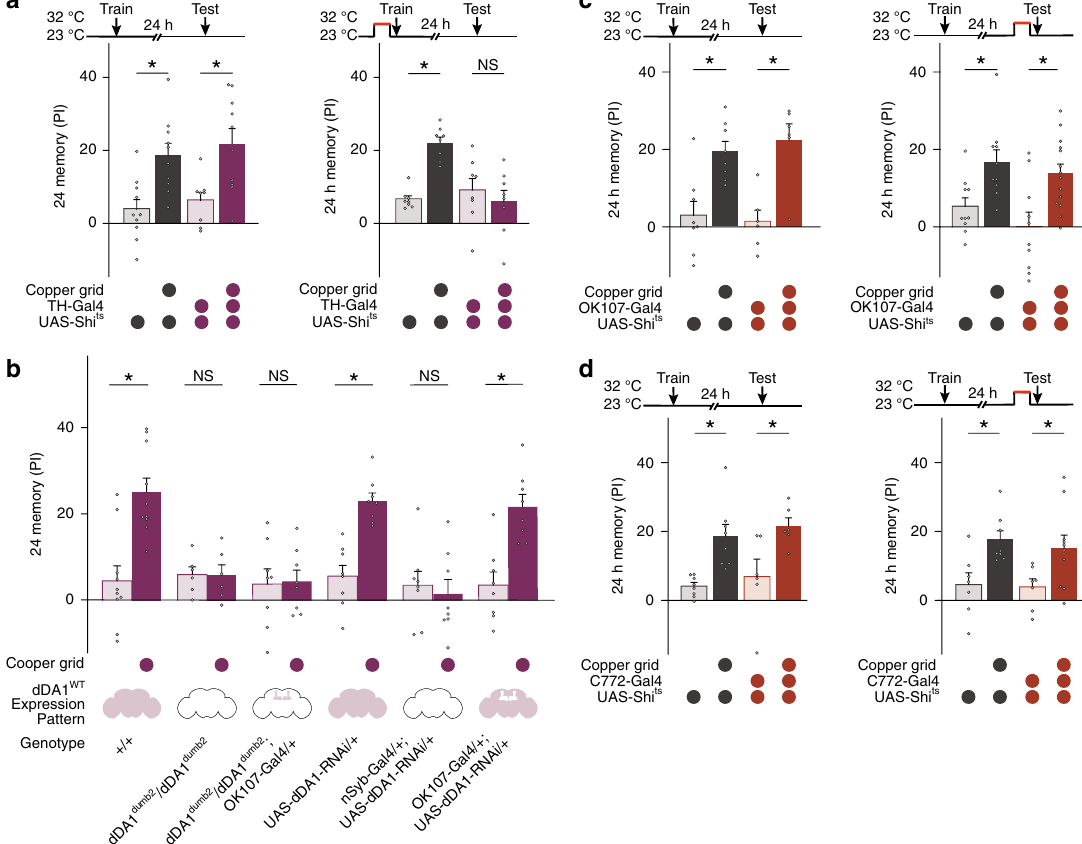
Fig. 2 cLTM requires dopaminergic neurons, but not the mushroom body. a Top: protocols. Temperature shifting is fi nished immediately before training to avoid inconsistency in temperature conditions. Bottom: blockade of dopaminergic neurons with TH-Gal4 and UAS-Shits during training abolishes context- dependent long-term memory (cLTM) formation ( n = 8 – 10). b Both mutant ( dDA1 dumb2 ) and knockdown dDA1 in pan neurons (nSyb-Gal4;UAS-dDA1- RNAi) abolish cLTM formation. Selective overexpression of dDA1WT in mushroom body (MB) in dDA1 dumb2 fl ies ( dumb2 ;OK107-Gal4) does not rescue cLTM. Selective knockdown of dDA1 in the MB (OK107-Gal4;UAS-dDA1-RNAi) does not impair cLTM ( n = 6 – 10). c , d Top: protocols. Temperature shifting is fi nished immediately before testing. Bottom: MB output is dispensable during cLTM retrieval ( n = 6 – 14). Data are mean performance indices ± SEM; individual data points are displayed as dots; * P < 0.05 by ANOVA or t